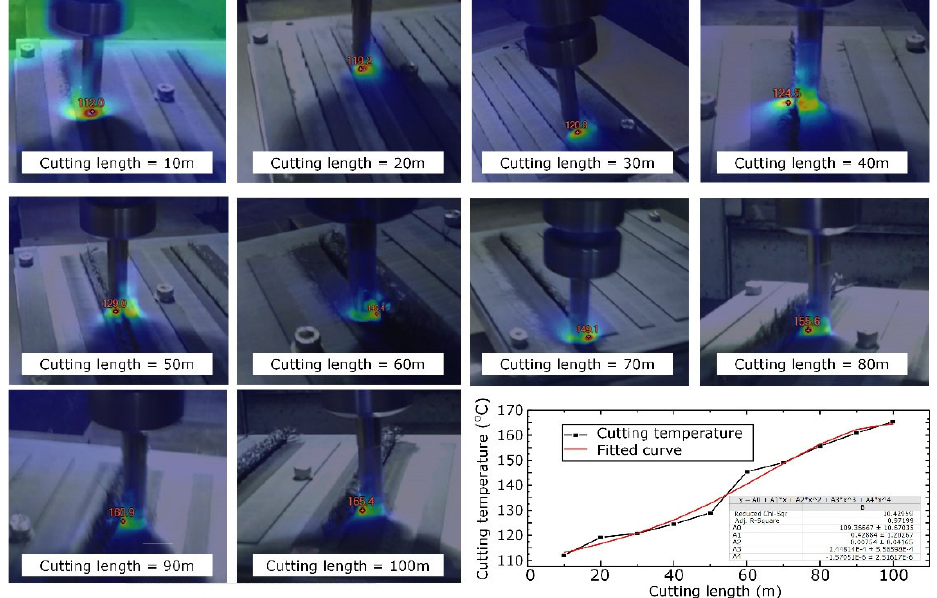
Figure 3. cutting temperature at different cutting lengths. Figure 3. Cutting temperature at different cutting